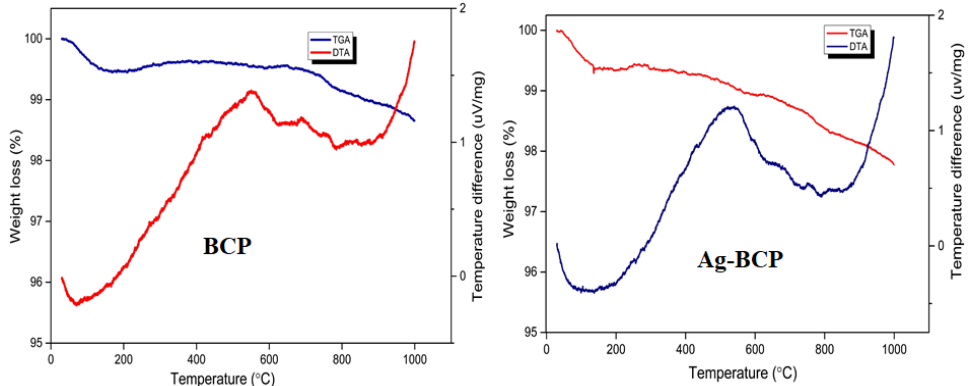
Figure 8. TGA and DTA analysis of BCP and Ag-BCP samples.